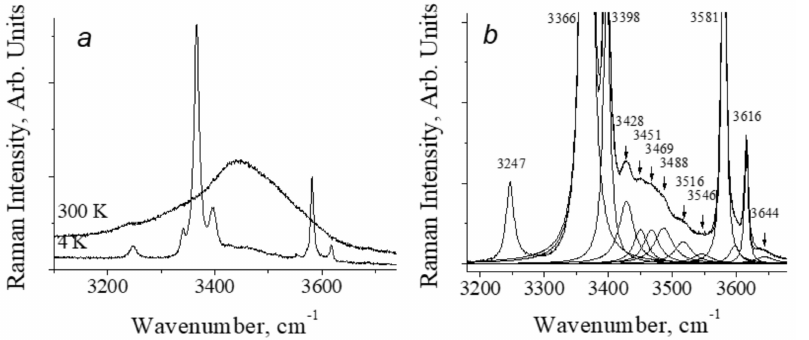
Figure 11. ( a ) Spectra of the stretching vibrations of H 2 O molecules and OH groups in the hemi- morphite cavity at 4 K and 300 K. The H 2 O molecule in the cavity forms a hydrogen bond with the OH groups of the crystal as a donor (lines ~3400 cm − 1 at 4 K) and as an acceptor (~3600 cm − 1 ); ( b ) Spectrum (4 K) of the combined modes of the stretching vibrations of H 2 O molecules in the cavity of hemimorphite with translational modes of H 2 O itself and of the lattice of the host crystal